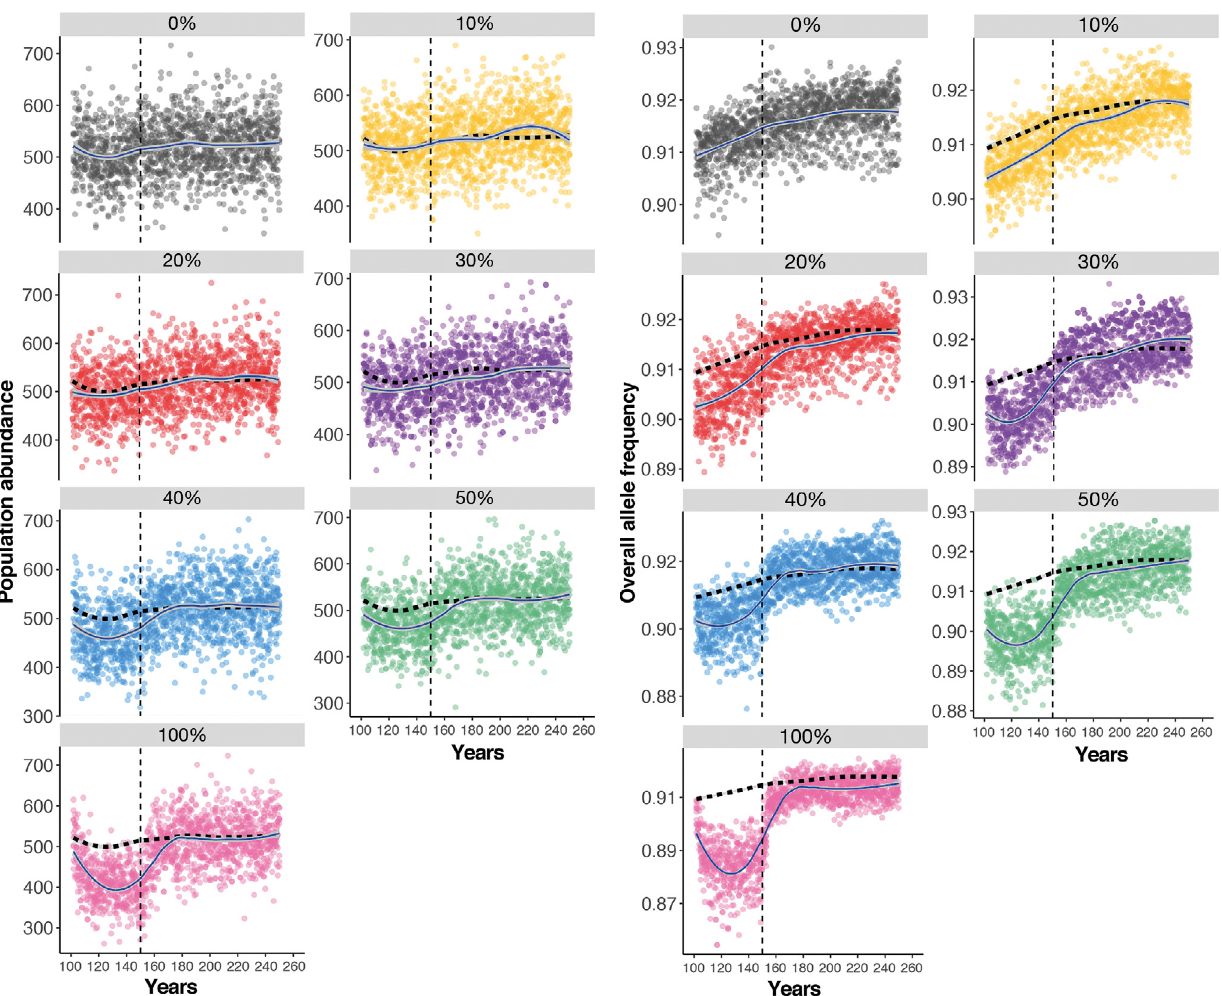
Fig. 2. Demographic changes over time during and follow- ing 50 yr of invasion by escaped farmed salmon in southern Newfoundland. All simulations were conducted using IB- SEM; see Section 2 and Castellani et al. (2015, 2018), Sylvester et al. (2019) for details. Horizontal dashed line represents the smoothed line of the zero-invasion simula- tion with 90% CI (grey shading); vertical dashed line repre- sents the end of simulated invasion of escaped farmed salmon. Solid blue lines represent the smoothed line of 10 replicates shown by the points. Smoothed lines were gener- ated using the geom_smooth function in the R package gg plot2 with the loess regression and a span of 0.5 100% displayed evidence of demographic decline (Fig. 2) and genetic change (Fig. 3) in the wild popu- lation. Overall, the magnitude of demographic de - cline and genetic change increased with increasing proportions of farm escapees present when com- pared to the no invasion scenario (Fig. 4). The magni- tude of demographic decline resulting from genetic changes ranged from ~0% under no invasion to